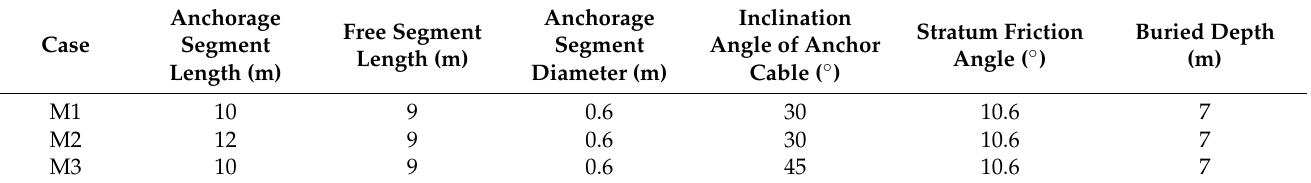
Table 1. Control parameters of expanded anchor cable.